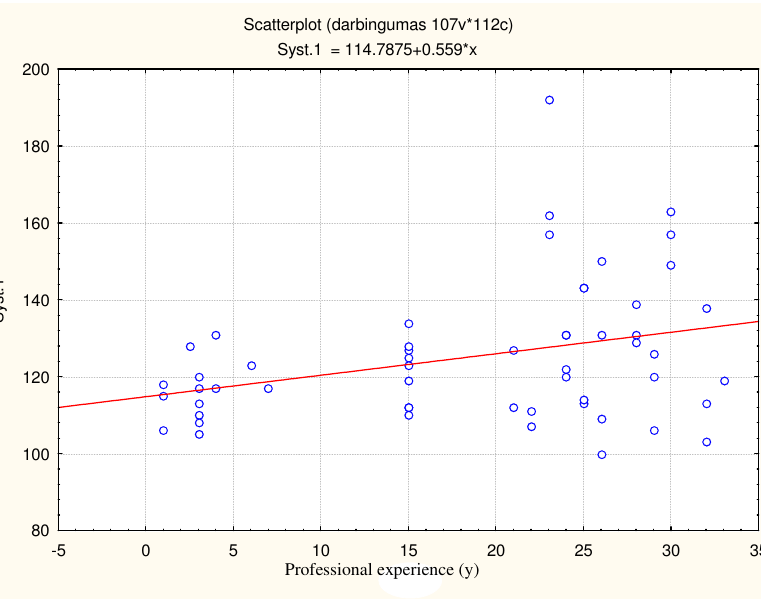
Fig 2. Age and arterial systolic blood pressure dependence